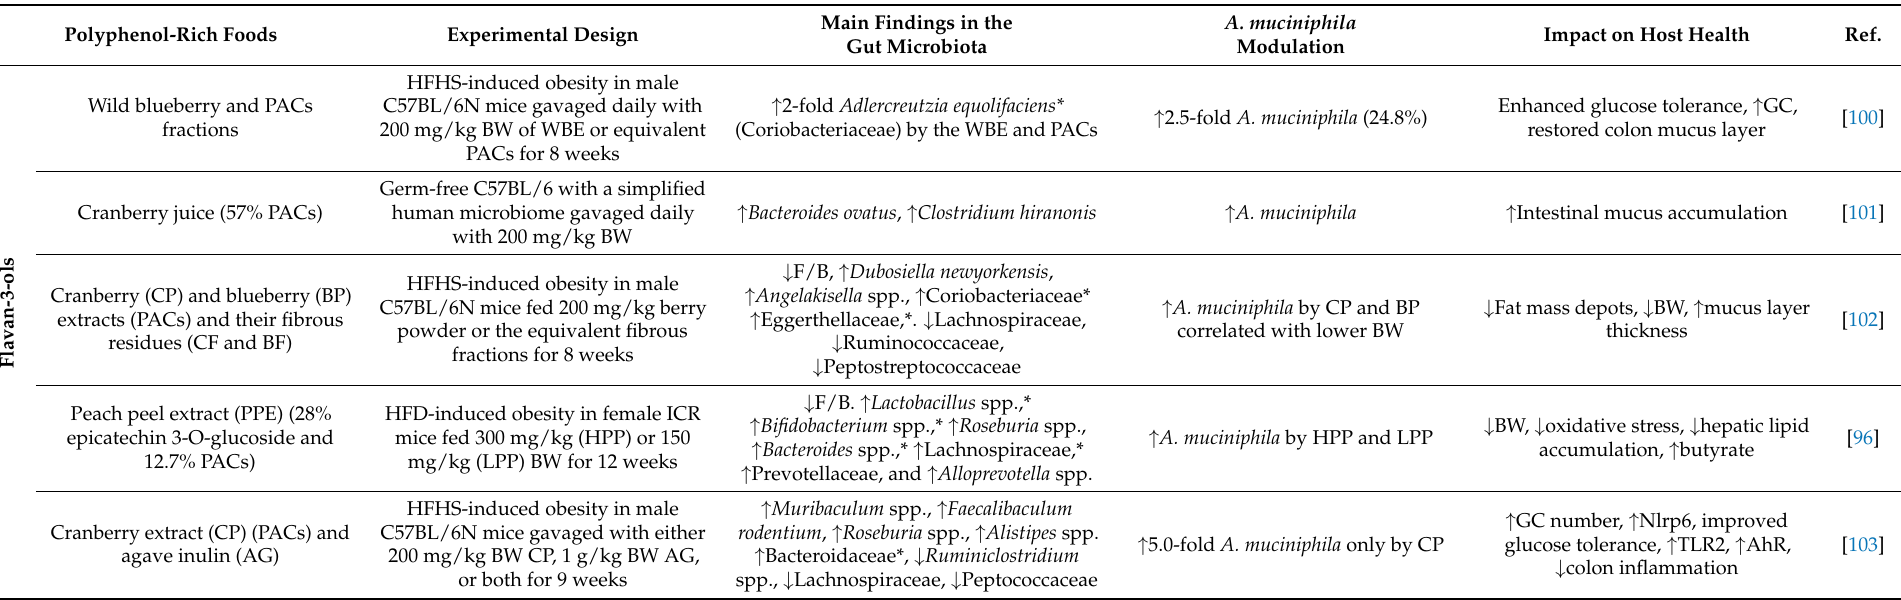
Table 2. Impact of flavan-3-ol consumption on the relative colonic abundance of A. muciniphila and other